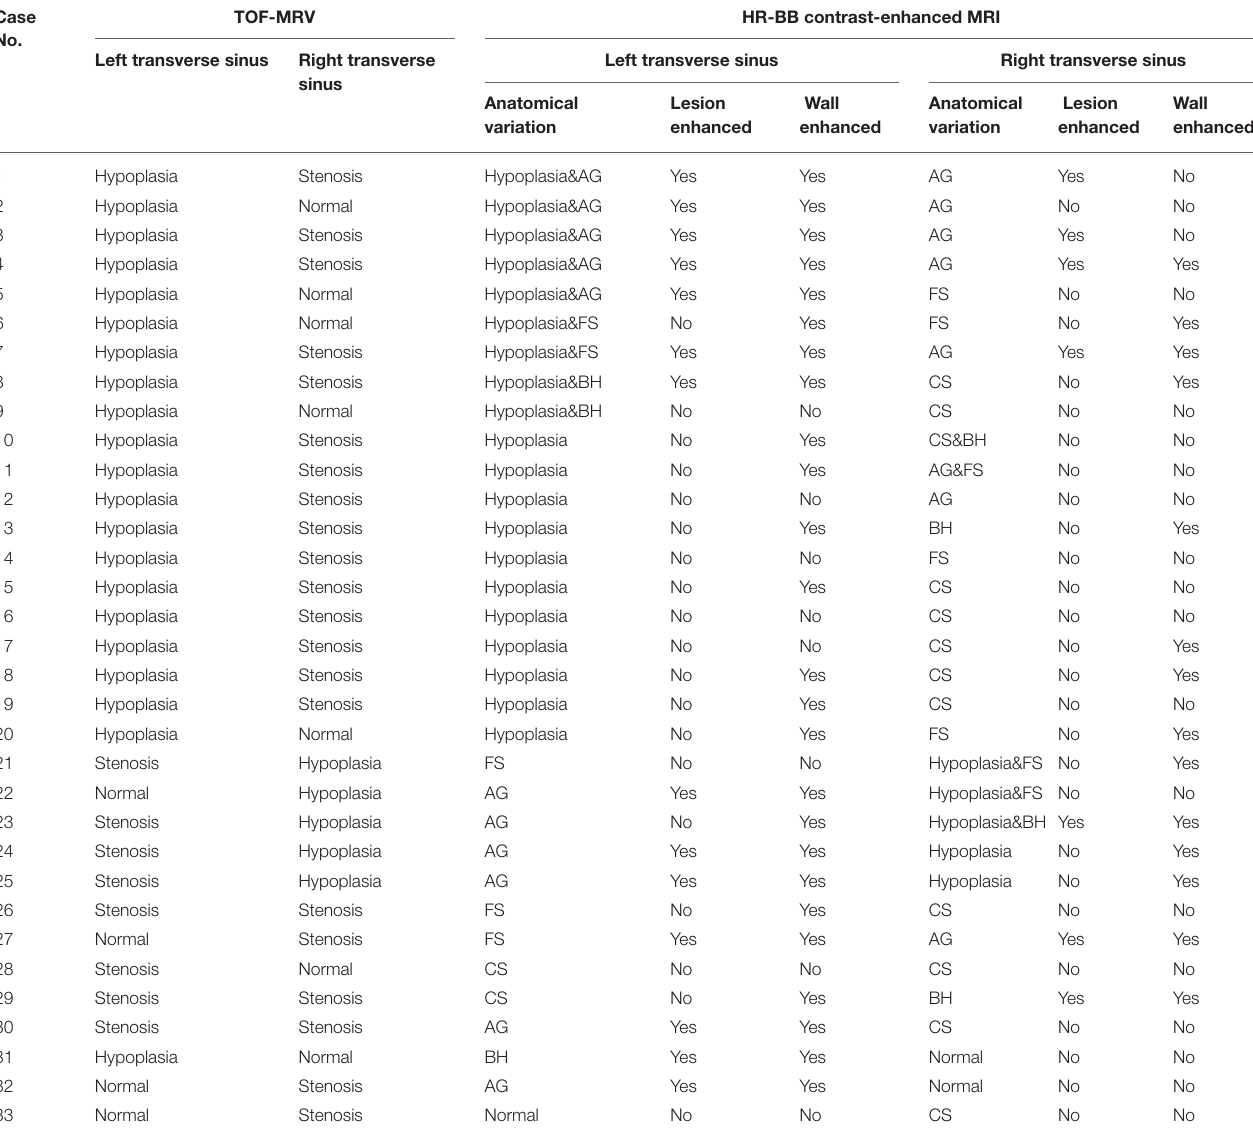
TABLE 3 | The anatomy of bilateral sinuses in 33 enrolled patients with IIH. Case